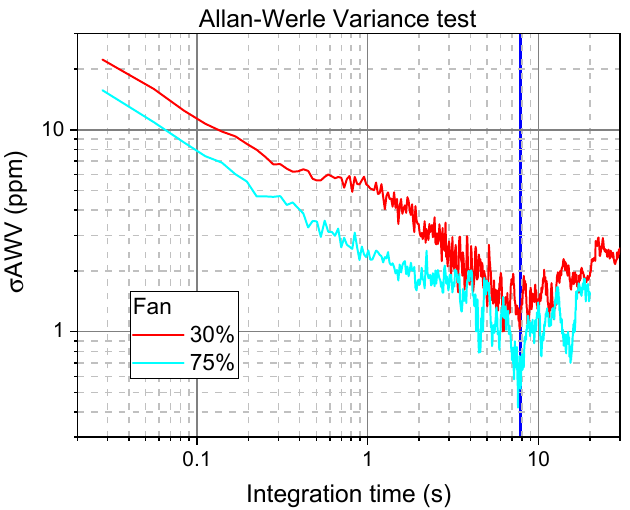
Figure 6. Allan-Werle test of the system at two different fan speeds, with respect to